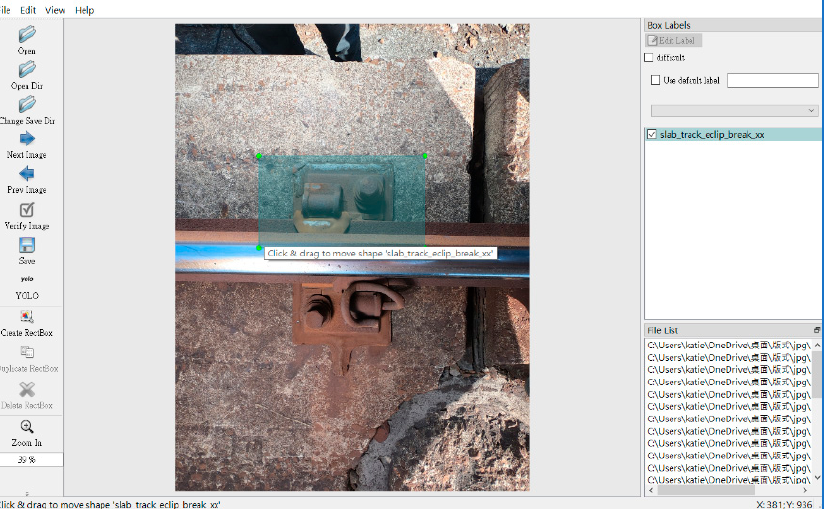
Table 9. YOLOv4 training results for each defective type in the top view.